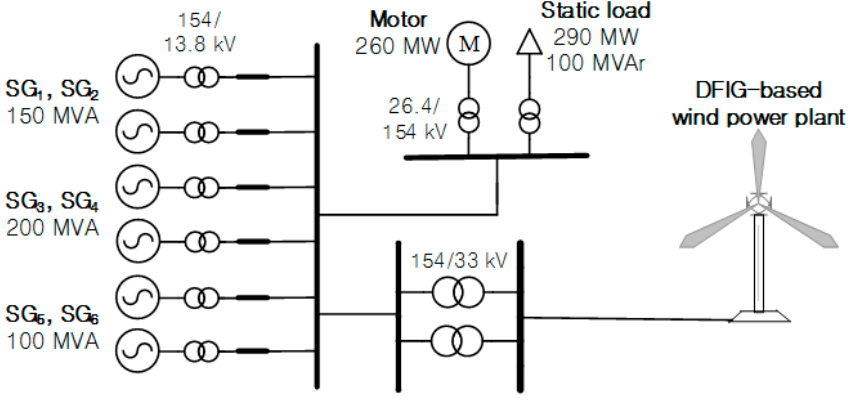
Figure 5. Model system with a DFIG-based wind power plant.